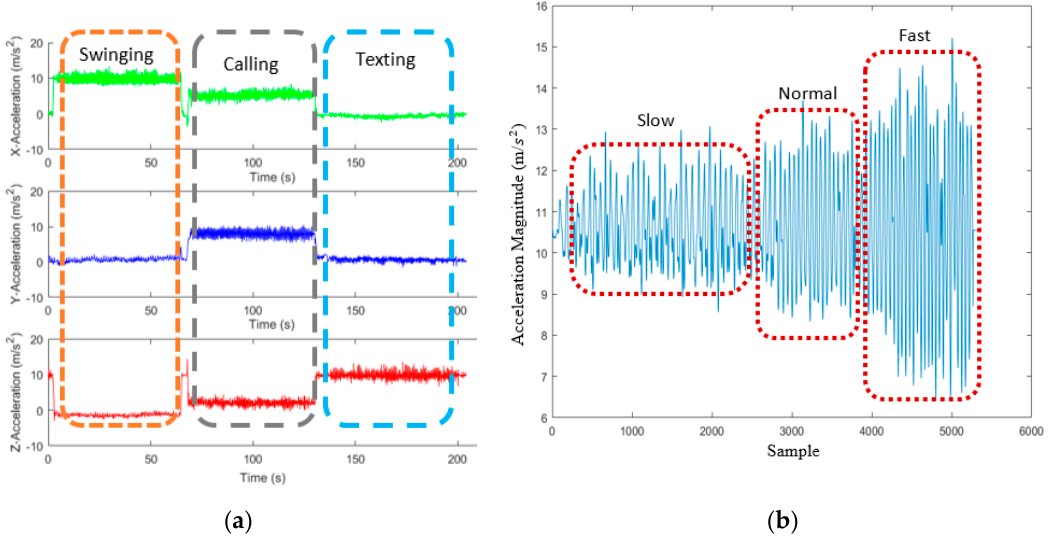
Figure 5. Comparison of acceleration data in different; ( a ) phone-carrying modes; ( b ) walking speeds.